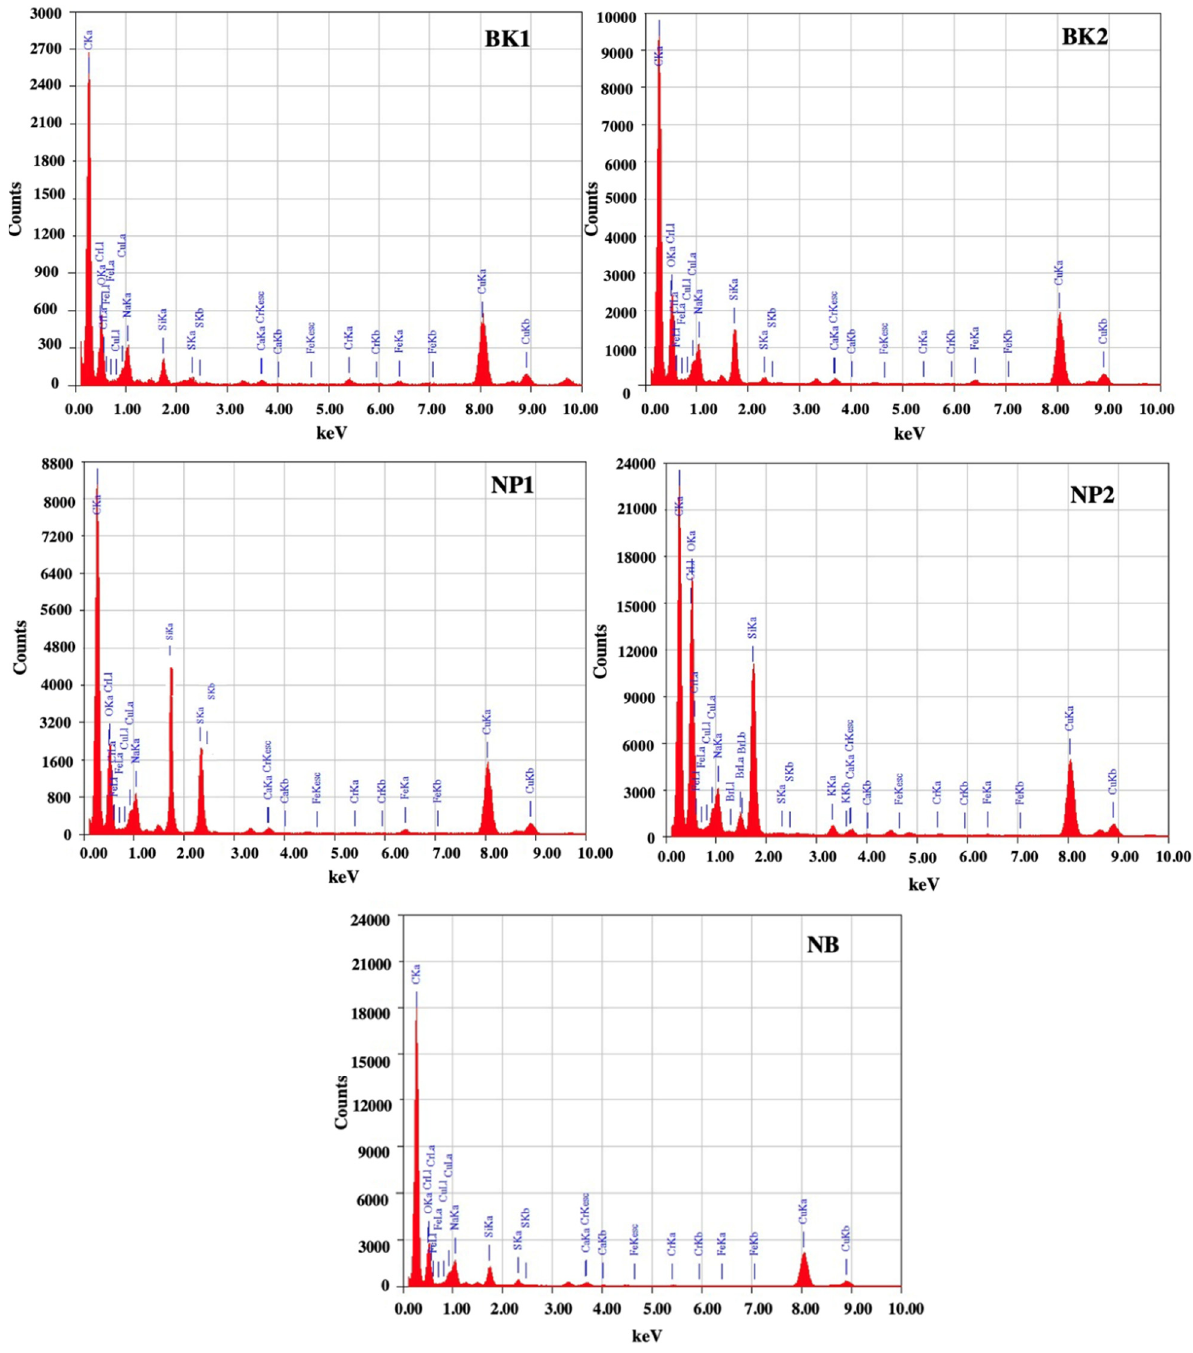
Figure 5. EDX spectra of particles in PM10 collected from various sampling sites.